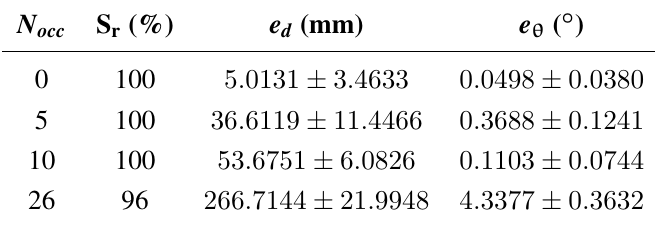
Table 8. L2-based DE-MC GL with different unmodeled obstacles. Robot’s location: (100, 100, 0). Errors are the mean ± standard deviation. Sensor noise: 1%